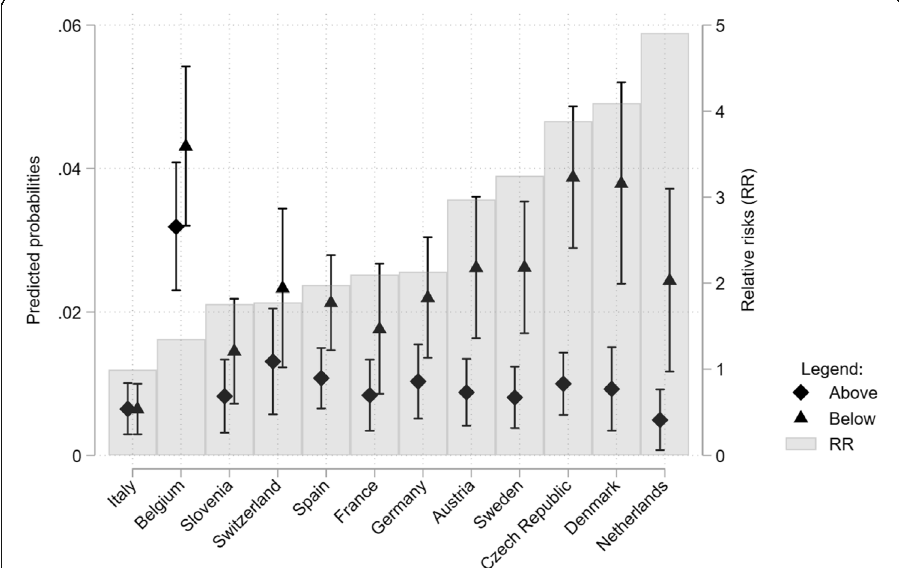
Fig. 4 Predicted probabilities (left axis) and 95% confidence intervals for individuals below the median income (triangles) and above median income (diamonds) and associate relative risks (RR; bars; right axis) of being in a nursing home by country, controlling for respondent ’ s sex, age, and health